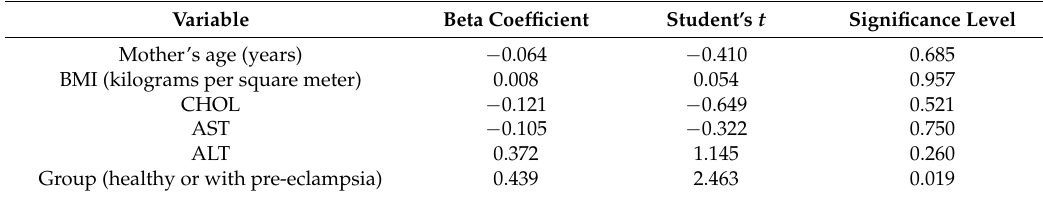
Table 6. Linear regression results regarding the left carotid artery intima–media